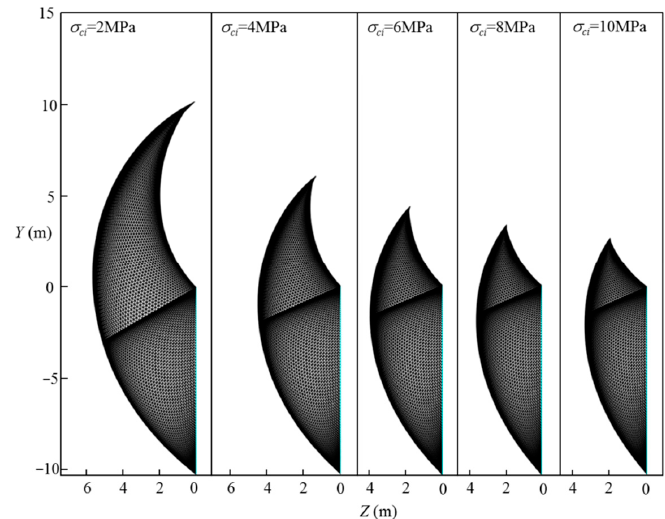
σ on the 3D failure surface. Figure 13. Effect of σ ci on the 3D failure surface. ci